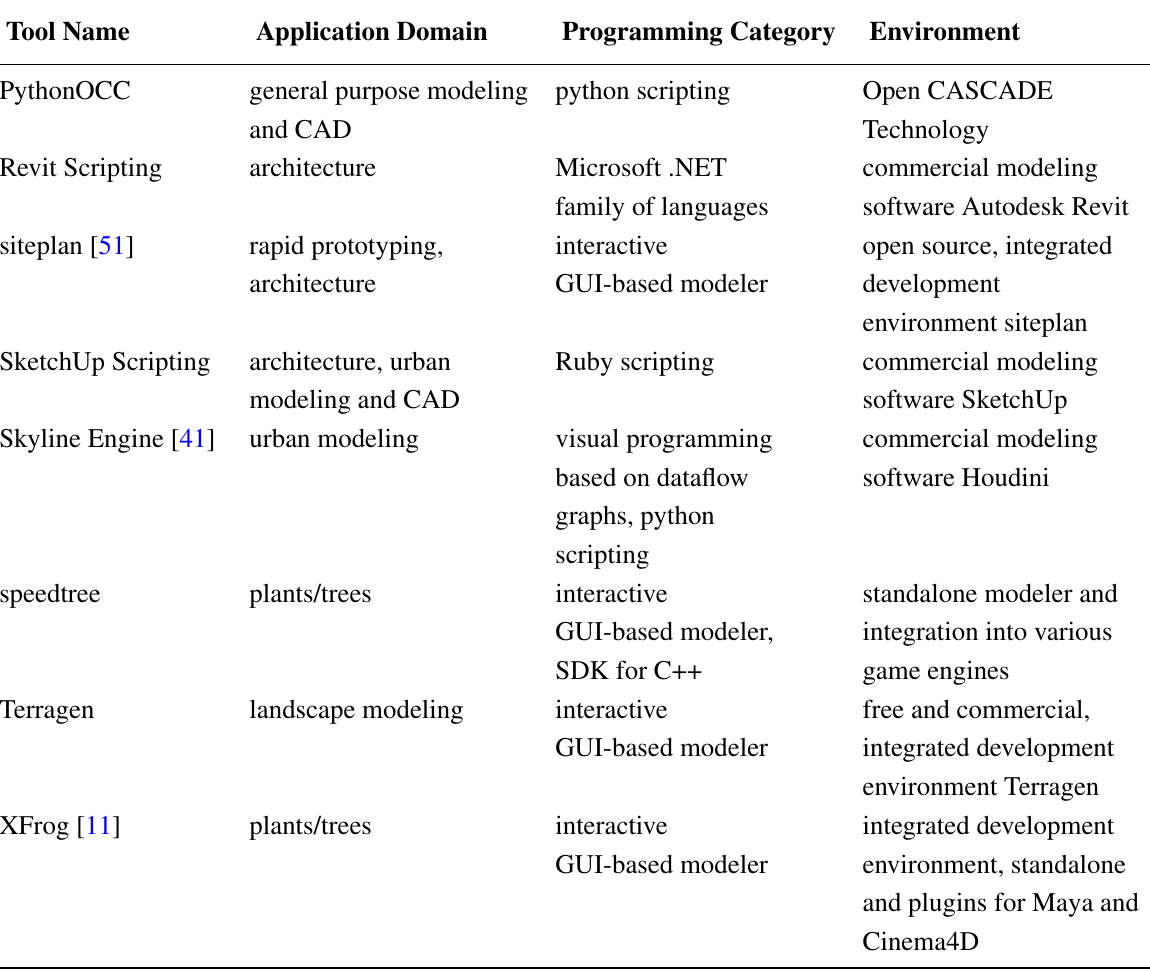
Table 2. Overview on generative/procedural 3D modeling tools and approaches (Part 2) Tool